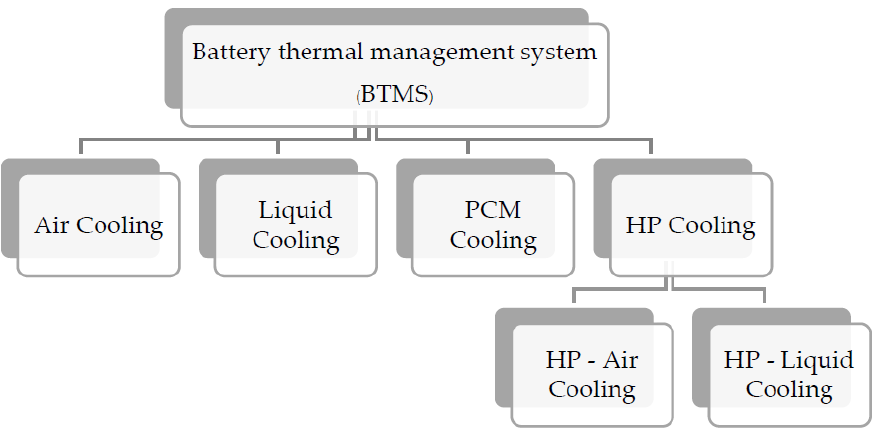
Figure 1. Classification of battery cooling systems.